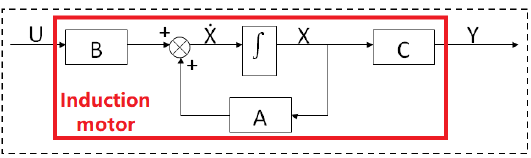
Figure 1. Mathematical model of the induction motor: state space.